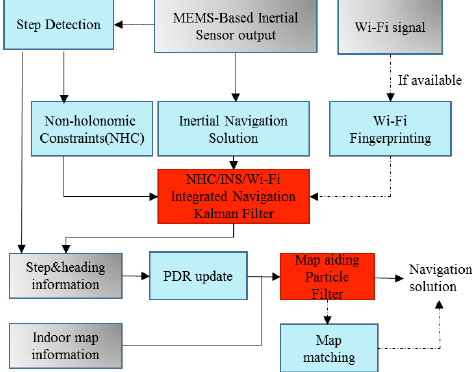
Figure 4. Map/INS/Wi-Fi integration algorithm using KF and